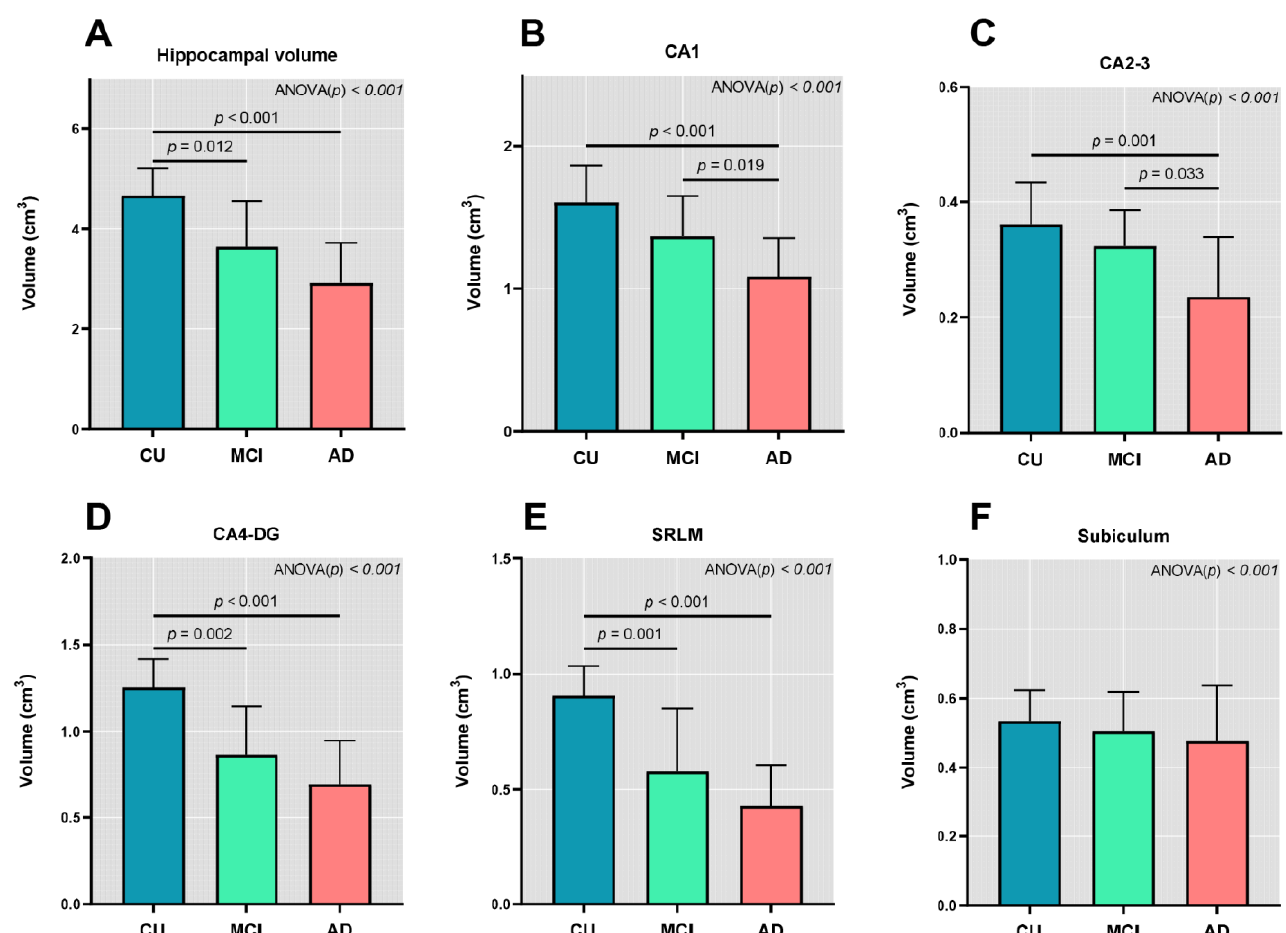
Figure 2. Between-group comparisons of the hippocampal subfield volumes. ( A ) Total hippocampal volume, ( B ) CA1, ( C ) CA2 – 3, ( D ) CA4-DG, ( E ) SRLM, ( F ) subiculum. Abbreviations: AD = Alzheimer’s disease, CU = cognitively unimpaired, MCI = mild cognitive impairment, CA = cornu ammonis, SRLM = stratum radiatum/lacunosum/moleculare.